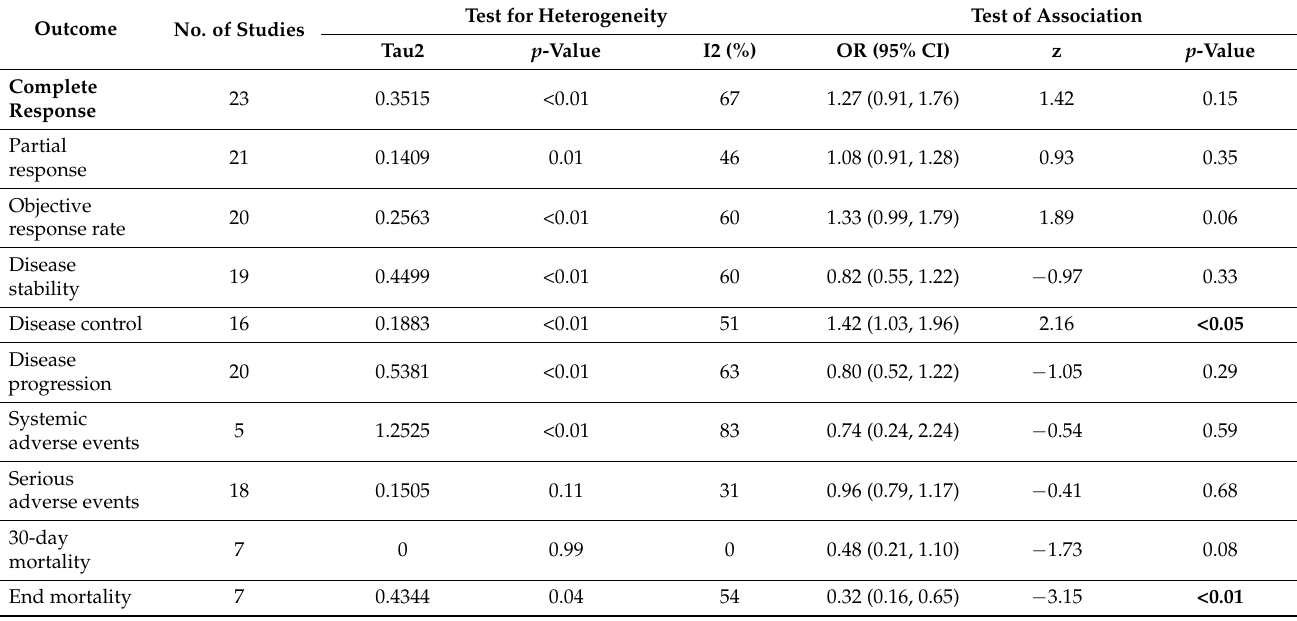
Table 2. Summary of the pooled analyses for the efficacy and safety